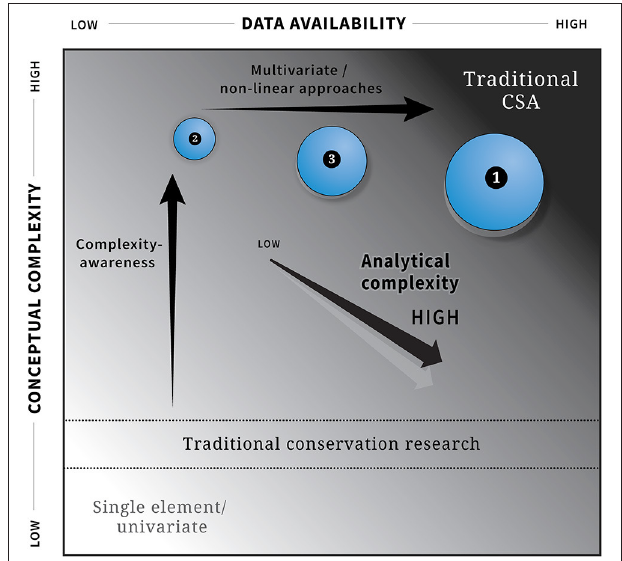
FIGURE 1 | The three dimensional complexity landscape represented by three axes: (a) data availability (x-axis), (b) conceptual complexity (y-axis), (c) analytical complexity (z-axis), where circle size denotes analytical complexity (larger circles represent higher analytical complexity). Traditional Complex System Analyses (CSA) are possible when conceptual complexity, analytical complexity and data availability are high. As conceptual complexity increases, an analysis or application becomes complexity-aware even when data availability or analytical complexity are low. The three examples discussed in the text (1) dynamic ocean management, (2) spatially-explicit risk assessment and (3) the integration of complexity into economic and social domains are shown relative to these three